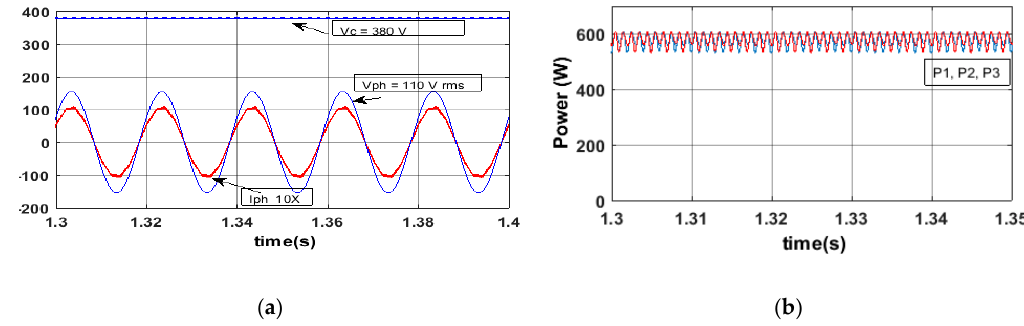
Figure 10. Steady-state response from numerical simulation of the multi-input operation ( a ) the capacitor voltage V C , the grid phase voltage V ph , and current I ph , ( b ) the PV power for each input.